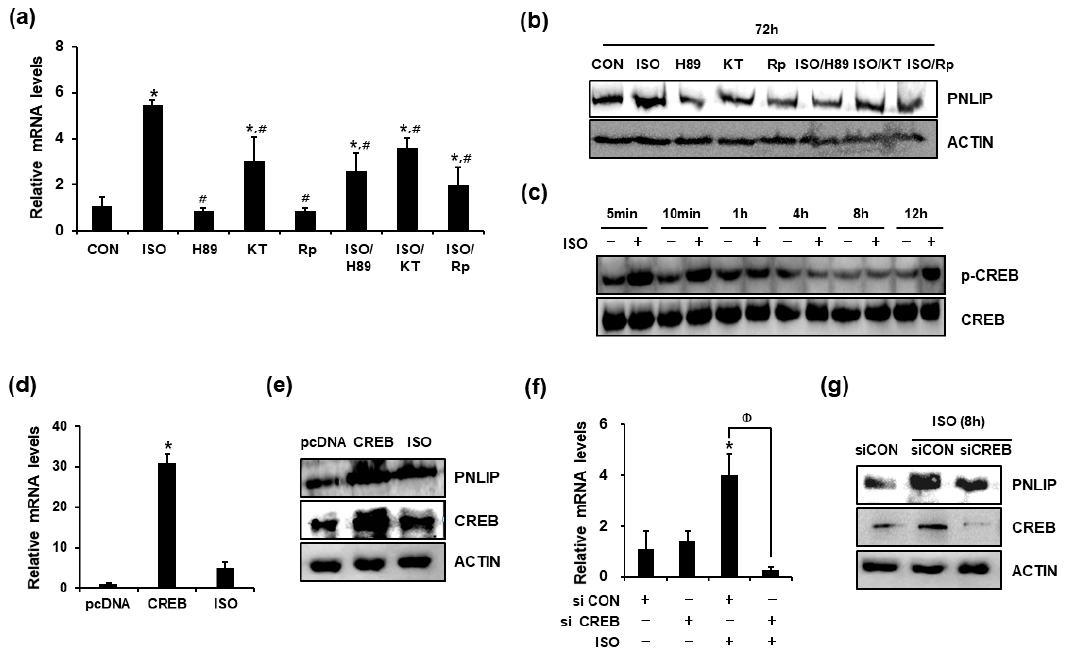
Figure 3. Isoproterenol enhanced the expression of PNLIP in a CREB-dependent manner. ( a , b ) The 266-6 cells were incubated for 72 h in the presence of the indicated reagents, and the PNLIP expression levels were examined using quantitative RT-PCR and western blotting analyses. * p < 0.05 vs. CON, # p < 0.05 vs. ISO. Rp, 10 nM Rp-cAMPs; KT, 5 µ M KT5720; H89, 20 µ M H89. ( c ) The 266-6 cells were incubated in the presence or absence of isoproterenol for the indicated periods and the levels of CREB and phosphorylated CREB were examined using western blotting analysis. ( d , e ) The 266-6 cells were transiently transfected with the pcDNA or CREB expression vector and incubated for 24 h. As a positive control, the 266-6 cells were treated with isoproterenol for 8 h. The levels of PNLIP and CREB mRNA and protein were then examined. * p < 0.05 vs. pcDNA. ( f , g ) The 266-6 cells were transfected with siRNA targeting CREB (siCREB) or non-targeting control siRNA (siCON) and incubated for 24 h. The cells were then incubated for an additional 8 h in the presence or absence of isoproterenol. The effect of the CREB knockdown on the expression of PNLIP mRNA and protein was then analyzed. * p < 0.05 vs. siCON, Φ p < 0.05 for the indicated pair.